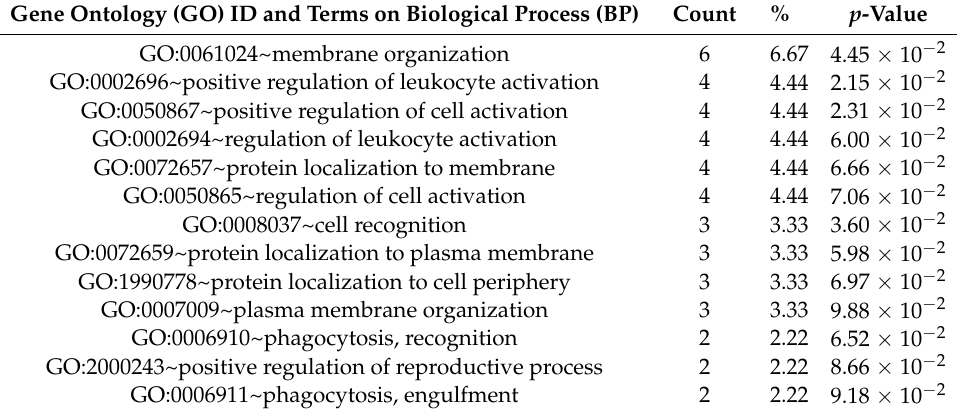
Table 1. The functional analysis of the upregulated genes at 1 h after Low Reactive Level Laser (LLL)